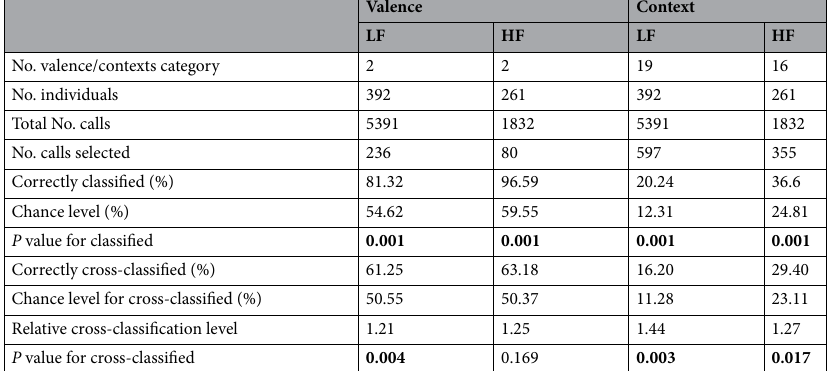
Valence Context